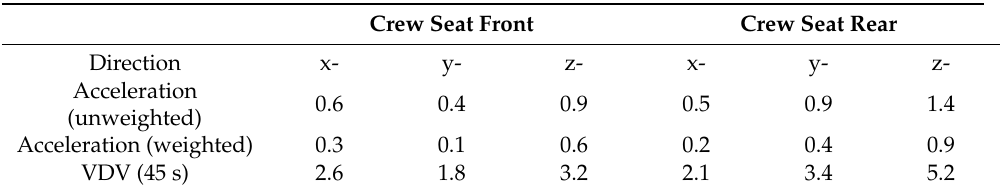
Table 2. Mean acceleration data recorded during 3 landings measured at crew seats on a Boeing 737-800. Data show unweighted and weighted r.m.s. acceleration (m/s 2 ) and vibration dose values (VDV, m/s 1.75 ) calculated over 45 s. Data from